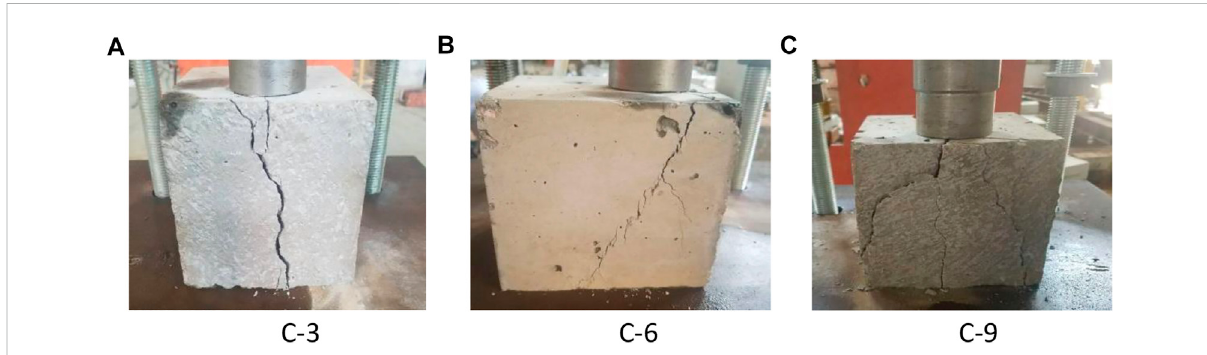
FIGURE 6 Failure mode of corroded specimen.